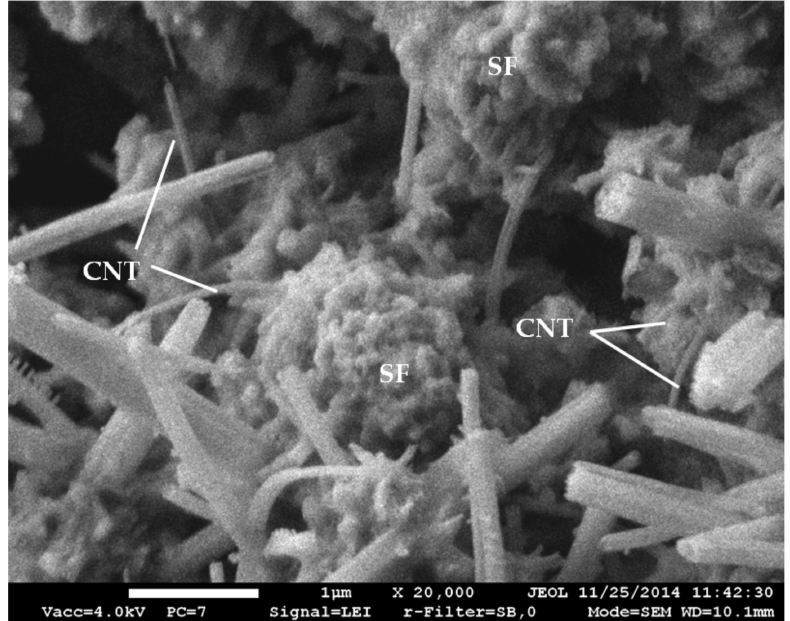
Figure 12. Morphology of cement hydration products modified with silica fume and nanotubes at an age of 28 days.